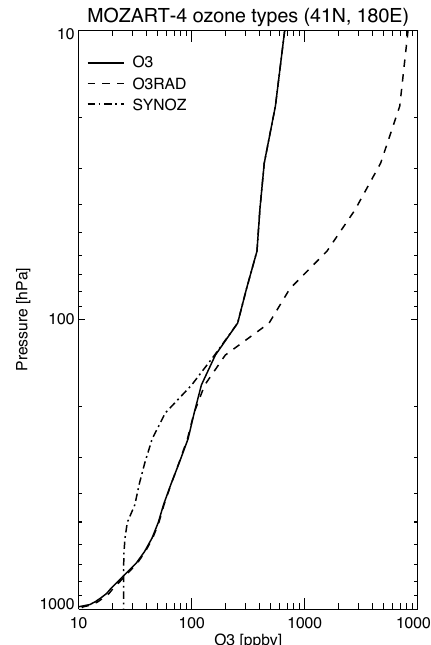
Fig. 3. Example profiles of the three ozone variables (O3, O3RAD and SYNOZ) used when including the SYNOZ parameterization. Shown is a monthly average profile for July 2006 at a point over the Pacific